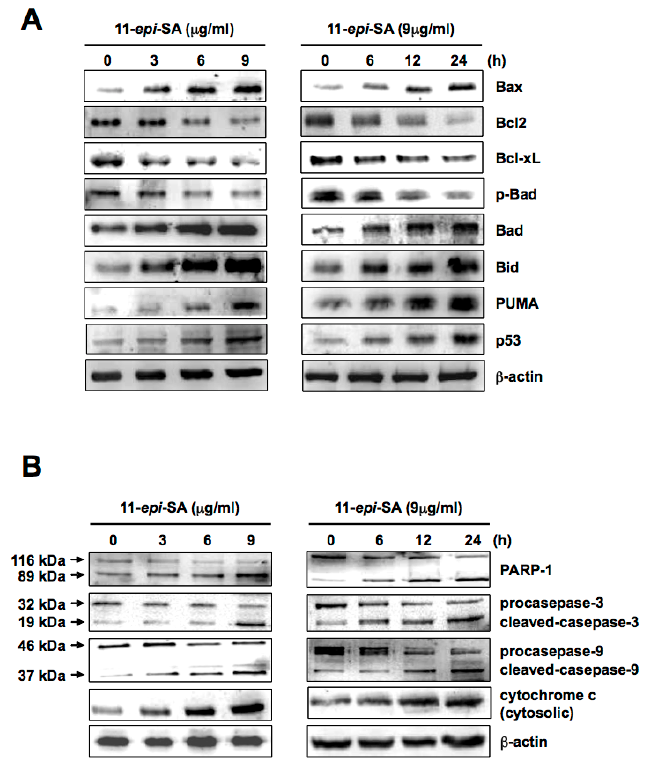
Figure 7. Treatment with 11- epi -SA activates mitochondria-related-apoptotic pathway proteins. ( A ) HA22T cells were treated without or with 11- epi -SA at different concentrations ( left ) and different time points ( right ) as indicated. The cells were then harvested and protein expression level was assessed by Western blotting using specific antibodies as indicated, and β -actin as loading control; ( B ) Caspase-dependent pathway proteins were activated in the 11- epi -SA-treated cells. The cell lysates were harvested after 11- epi -SA treatment as indicated above, followed by the examination of poly(ADP-ribose) polymerase 1 (PARP-1), caspase-3, -9, and cytochrome c proteins by using the specific antibodies as indicated. β -actin was used as the loading control.